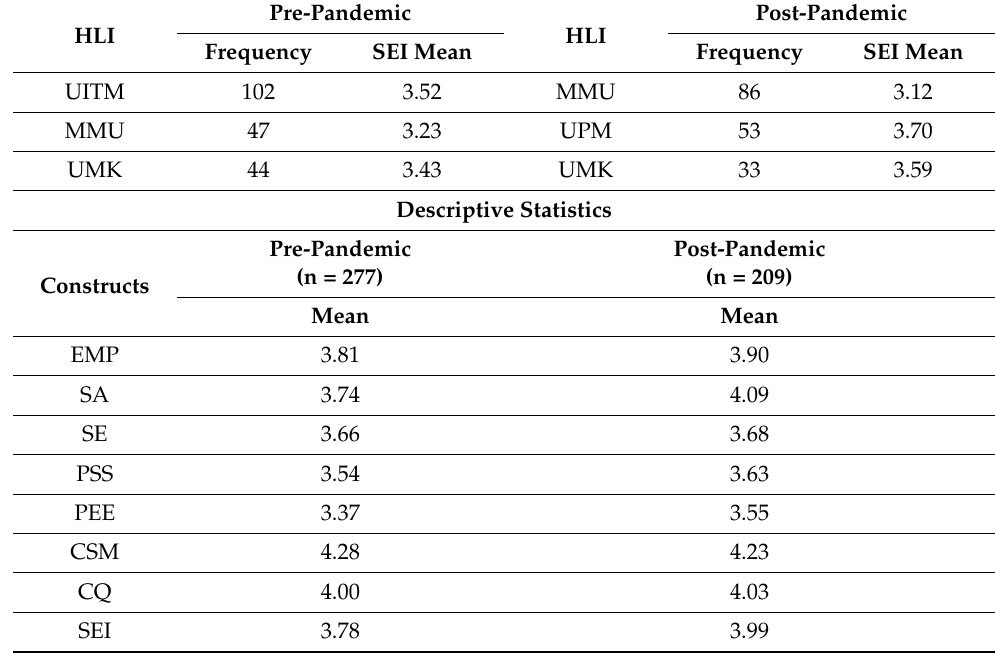
Table 4. Social entrepreneurship level.